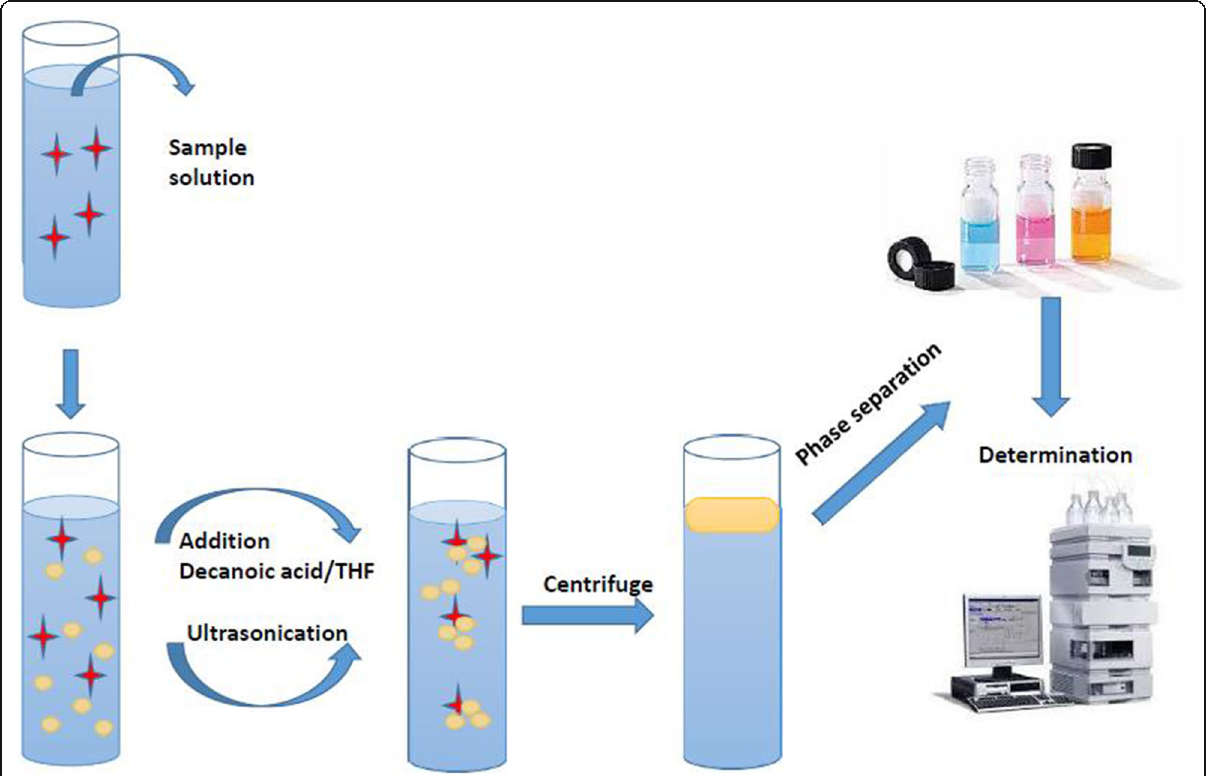
Fig. 1 Schematical diagram of the developed liquid phase microextraction